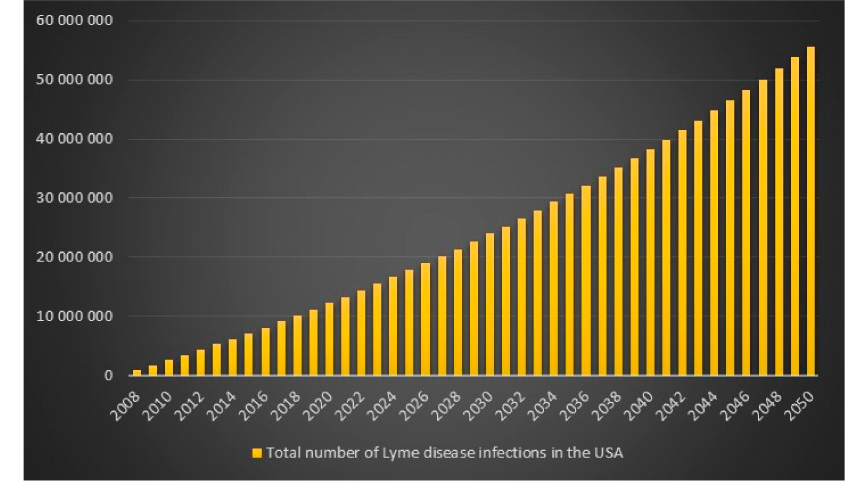
Figure 11. Total number of Lyme disease infections in the USA between the years 2008 to